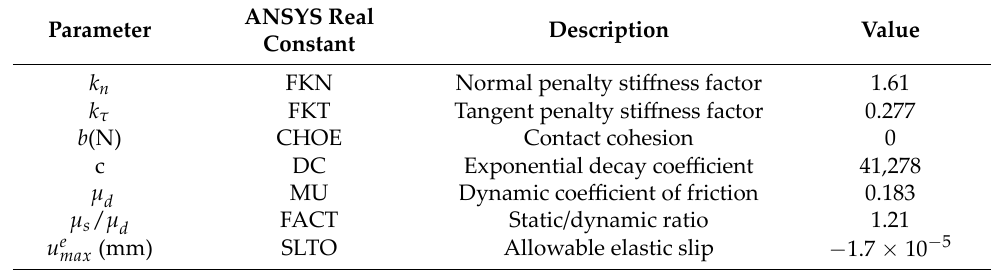
Table 2. Parameters setting for the contact